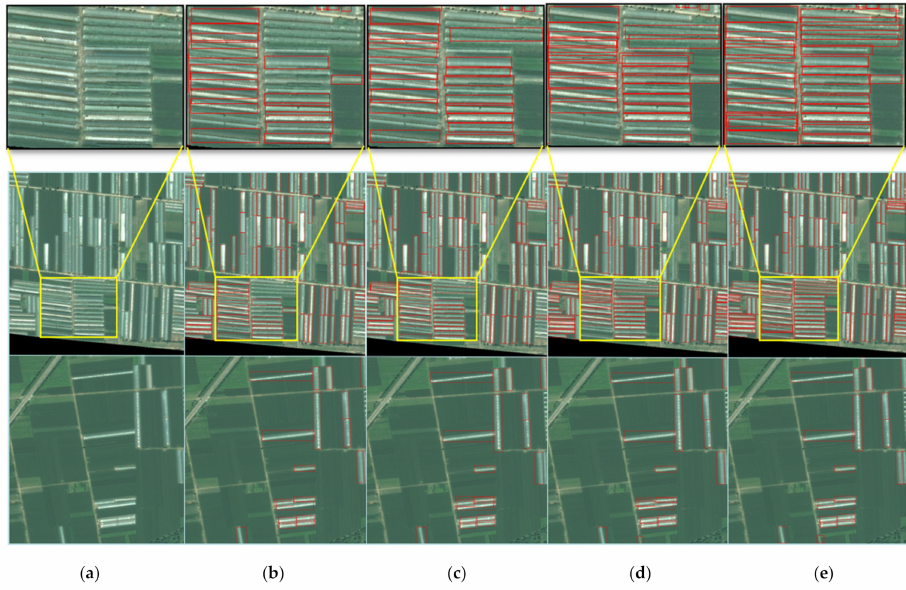
Figure 7. Greenhouse quantity extraction results for concentrated distribution (the first line) and scattered distribution (the second line). ( a ): Ground Truth ( b ): YOLOX ( c ): YOLOX+CBAM ( d ): YOLOX+ASFF ( e ): YOLOX+CBAM+ASFF.